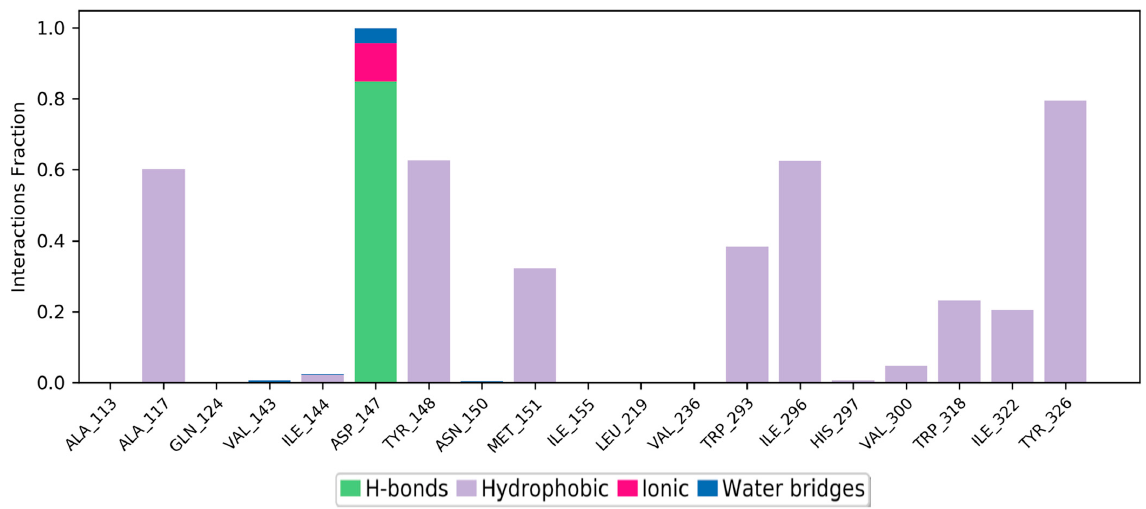
Figure 7. Simulation interaction diagram (SID) plot showing the protein–ligand interactions between the binding site and etazene. The stacked bar charts include the fraction of occupancy, among all of the MD simulation snapshots. Footnotes: The stacked bar charts are normalized over the course of the trajectory; for example, a value of 0.8 suggests that for 80% of the simulation time, the specific interaction is maintained. Values over 1.0 are possible as some protein residues may make multiple contacts of the same subtype with the ligand.